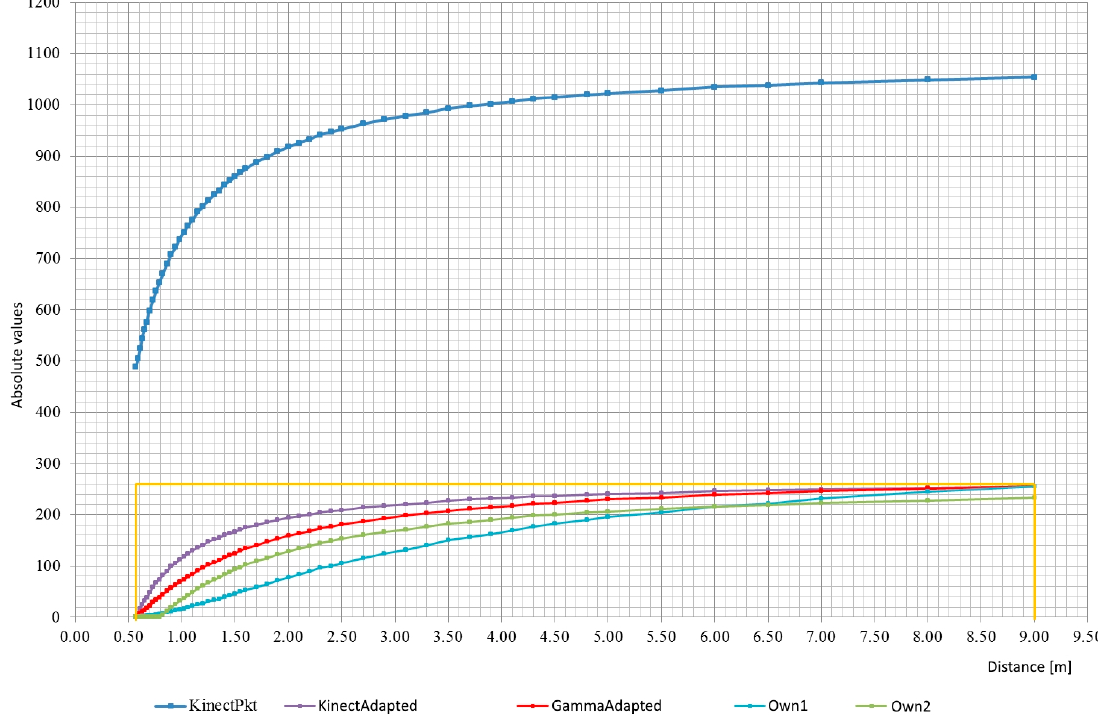
Figure 3. Graphs of functions converting raw distance data (up to 9 m) into useful values in the range of 0–255. The chart labeled KinectPkt shows the raw values returned by the sensor. Orange lines limit the field of the graph in which the useful range of the actual distance is located and the distance between the range 0–255 is returned by the sensor.